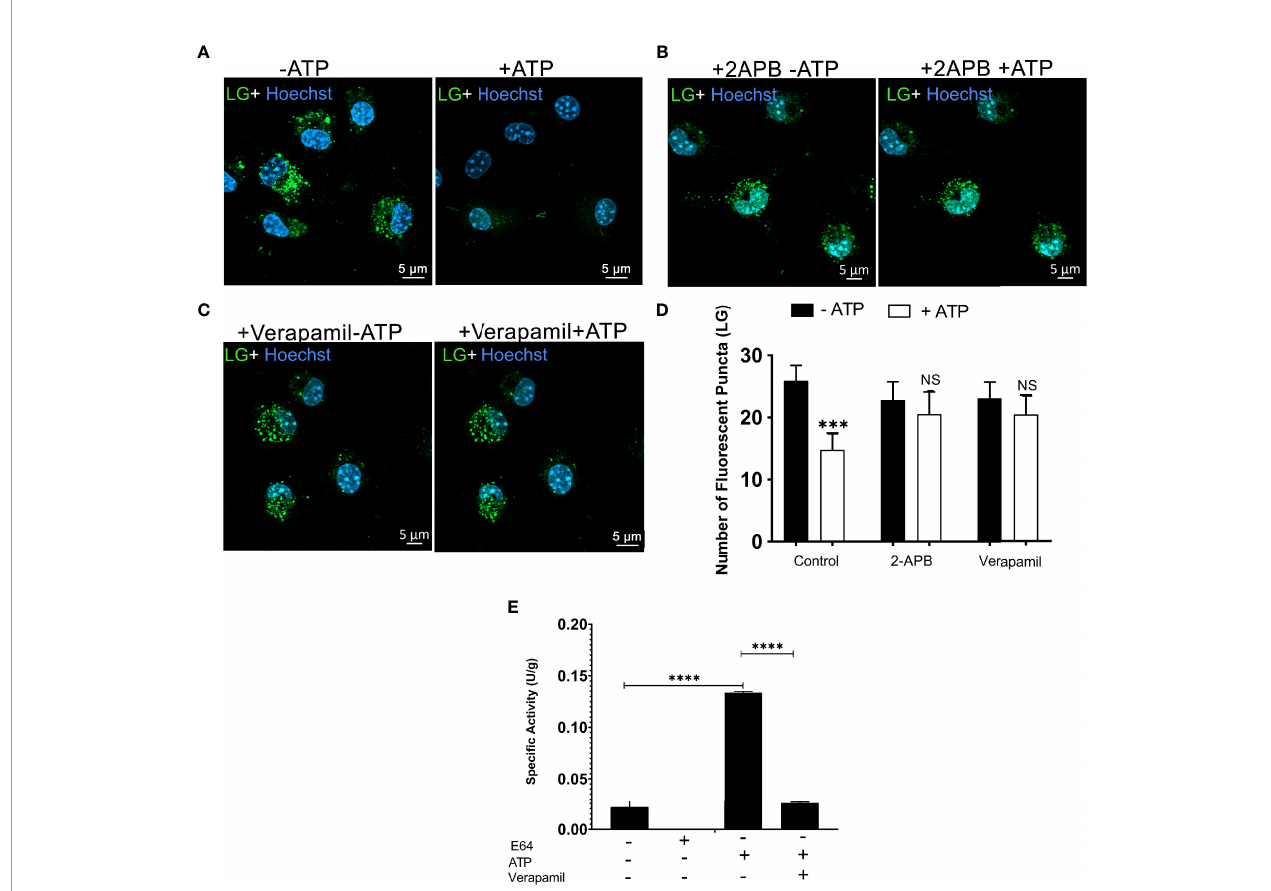
FIGURE 5 | Calcium-Dependent Lysosomal Ion Channels Possible Mediate P2X7 Receptor-induced Lysosomal Rupture. Representative images of WT peritoneal macrophages labeled with 50 nM Lysotracker Green (LY) for 45 min (A) without treatments of inhibitors (B) WT peritoneal macrophage pre-incubated with 50 µM 2- APB, or (C) 50 µM verapamil for 30 minutes, and then treated or not with 5 mM ATP for 10 minutes. (D) The number of lysosomes stained with Lysotracker Green was counted before and after treatments. (E) Cathepsin activity in supernatants of cells pretreated with 50 µM of verapamil and treated or not with 5 mM ATP for